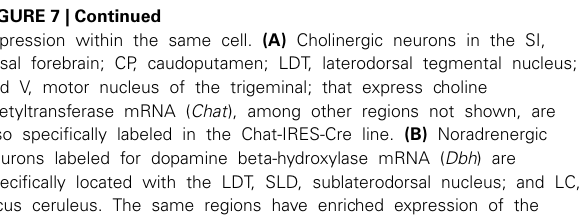
FIGURE 7 | Continued expression within the same cell. (A) Cholinergic neurons in the SI, basal forebrain; CP, caudoputamen; LDT, laterodorsal tegmental nucleus; and V, motor nucleus of the trigeminal; that express choline acetyltransferase mRNA ( Chat ), among other regions not shown, are also specifically labeled in the Chat-IRES-Cre line. (B) Noradrenergic neurons labeled for dopamine beta-hydroxylase mRNA ( Dbh ) are specifically located with the LDT, SLD, sublaterodorsal nucleus; and LC, locus ceruleus. The same regions have enriched expression of the